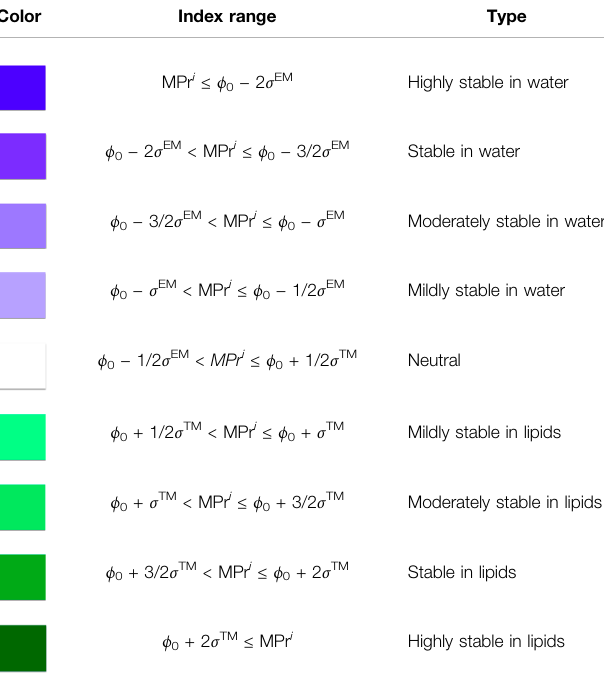
TABLE2| ClassesofMPrscoresde fi nedintermsoftheclassi fi cationthreshold ϕ 0 de fi ned in section 2.6 and the standard deviations σ ™ and σ EM of the MPr distributions computed from D TM mem and D EM mem , respectively. The colors used in the visualization frameworks of the BRANEart web server are here de fi ned.